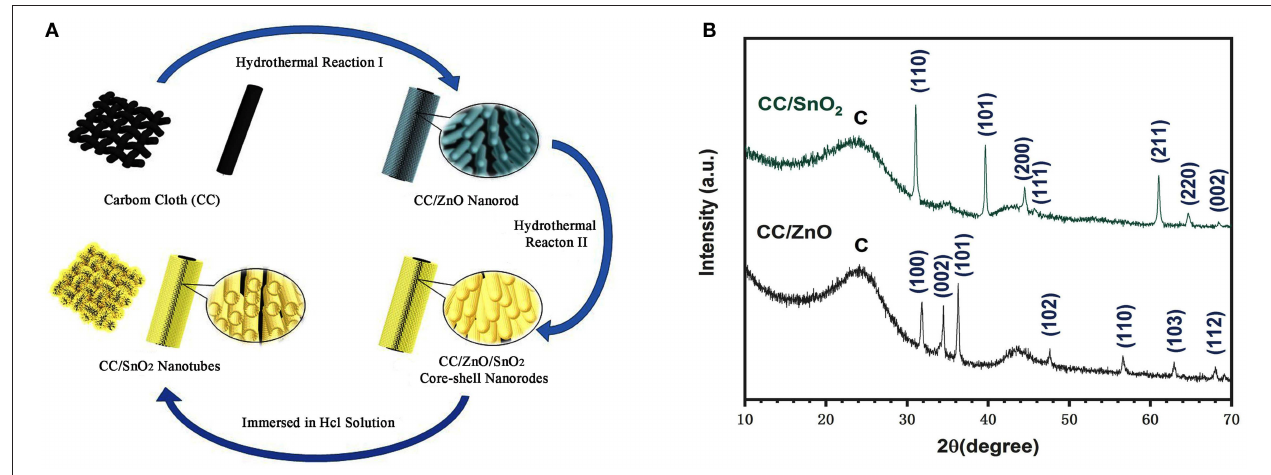
FIGURE 1 | (A) Schematic illustration of the synthesized procedures of 1D binder-free porous CC/SnO 2 nanotube arrays. (B) XRD pattern of 1D binder-free porous CC/SnO 2 nanotube